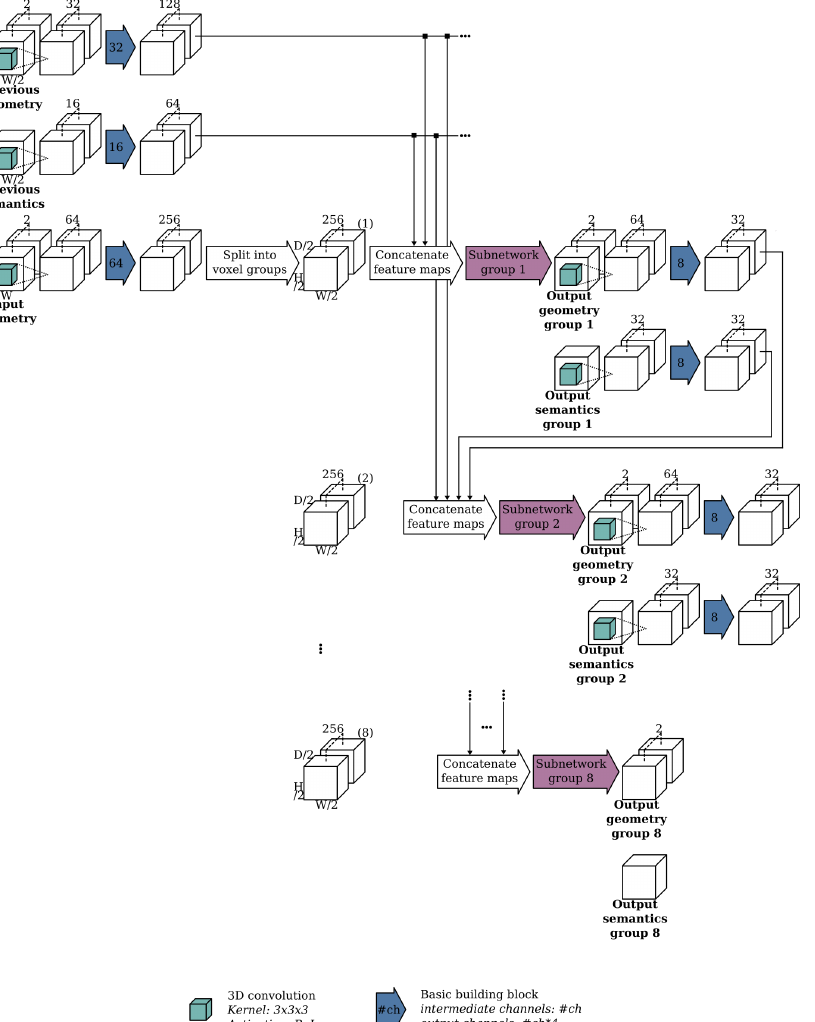
Figure 6. Overview of our optimized architecture of the 3D CNN for a single hierarchy. The blue arrows represent the basic building block as shown in Figure 4. For each basic building block, the parameter value is displayed that represents the number of channels used by the 3D convolutions from the basic building